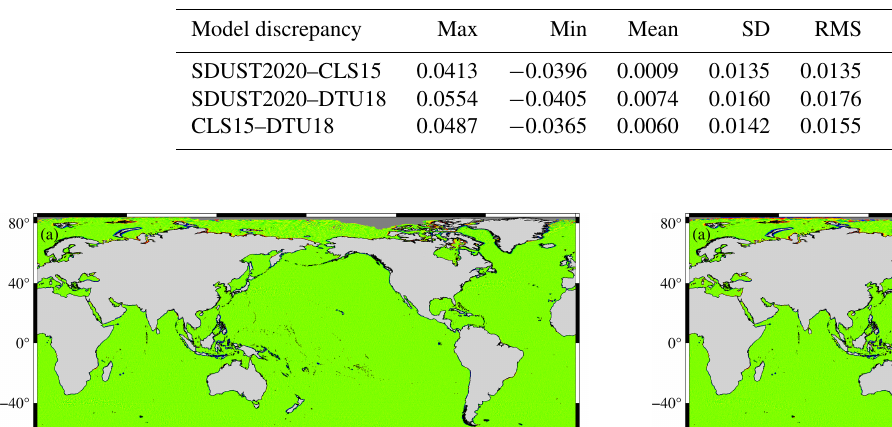
Table 6. Statistical results of comparisons between different mean sea surface models after rejecting outliers in differences by three times SD (unit: m).